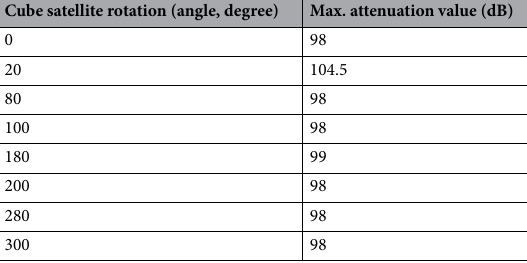
Cube satellite rotation (angle,